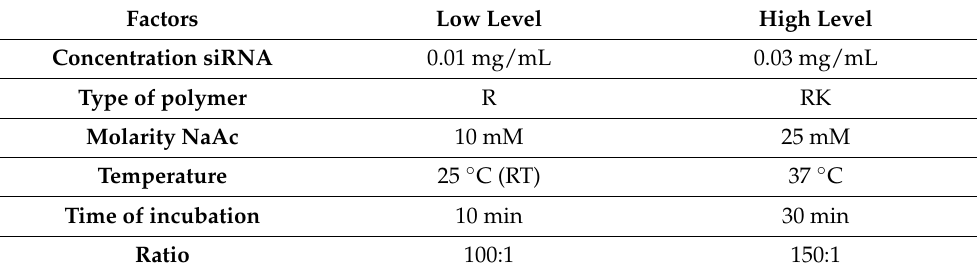
Table 2. DoE design for the selection of the most efficient nanoparticles synthesis.